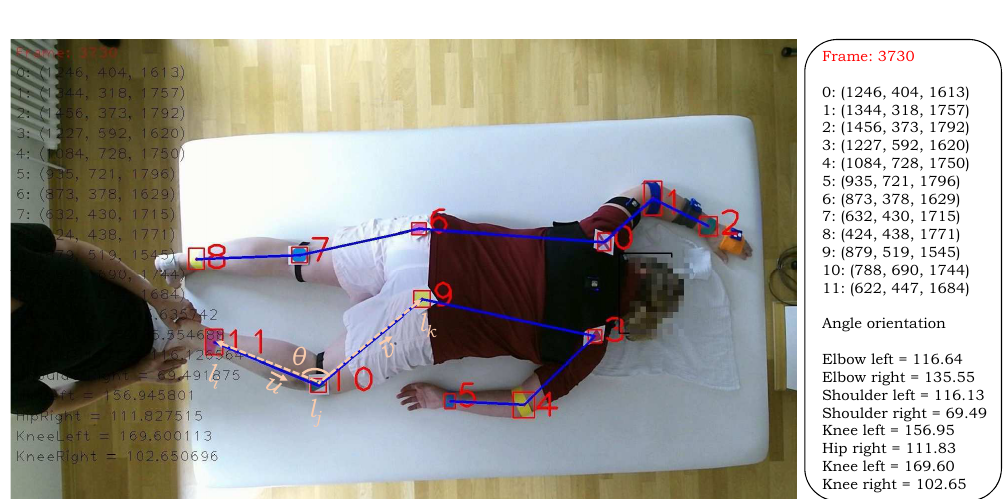
Figure 4. A sample image showing the position of markers on the human body. The markers are labeled from 0 to 11; their 3D position (horizontal-axis, vertical-axis, and its depth), and angle orientations at different joints are annotated at the right side of the image. The way of angle computation at the right knee is also